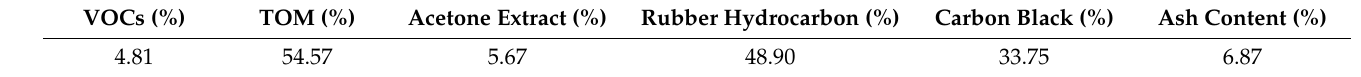
Figure 3. The thermogravimetric curve of crumb rubber sample with 30 mesh. Table 2. The composition results of the crumb rubber sample with 30 mesh.